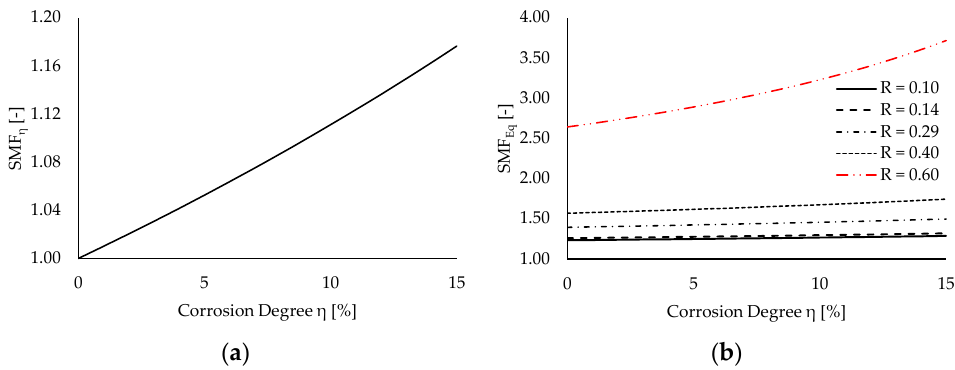
Figure 7. Trends of SMFs for increasing values of corrosion degree η : ( a ) corrosion-depending SMF η and ( b ) mean-stress-depending SMF Eq .